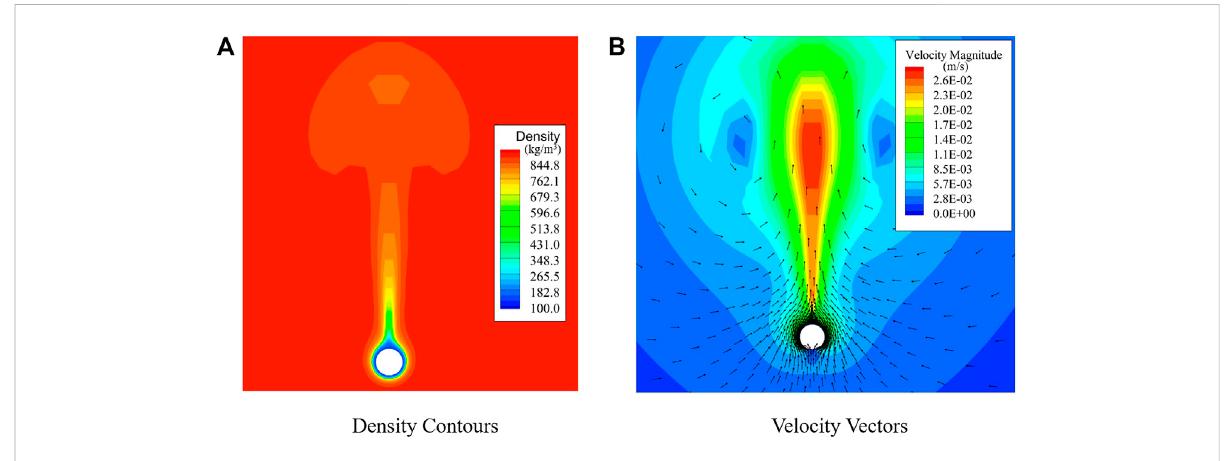
FIGURE 12 (A) Density contour and (B) velocity contour and vectors at 7.5 MPa with 90 K